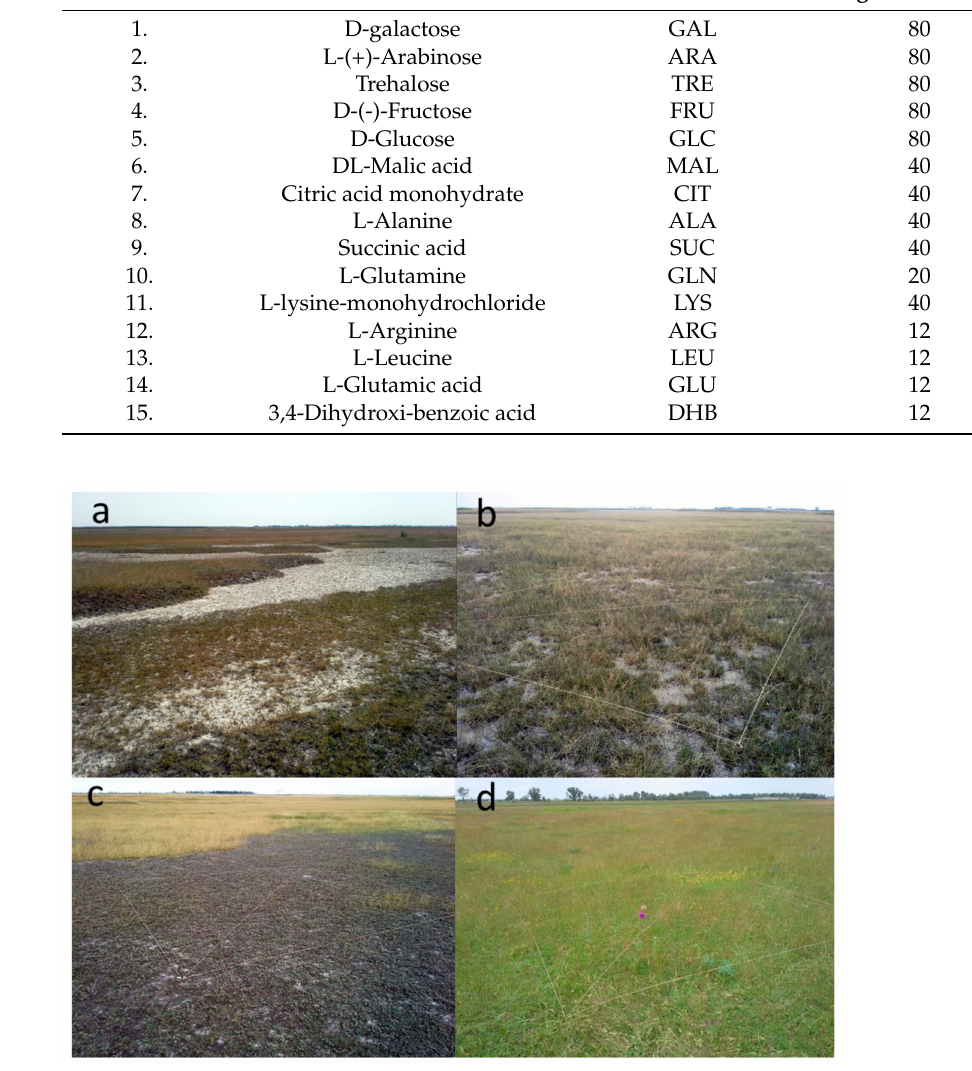
Figure 3. Salt-affected communities at Apajpuszta: ( a ) Lepidio crassifolii-Camphorosmetum an- nuae (CAM) in the depressions, ( b ) Lepidio crassifolii-Puccinellietum limosae (PUC), ( c ) Artemisio santonici-Festucetum pseudovinae (ART) with “Puccinellietum” in the background, ( d ) Achilleo setaceae- Festucetum pseudovinae